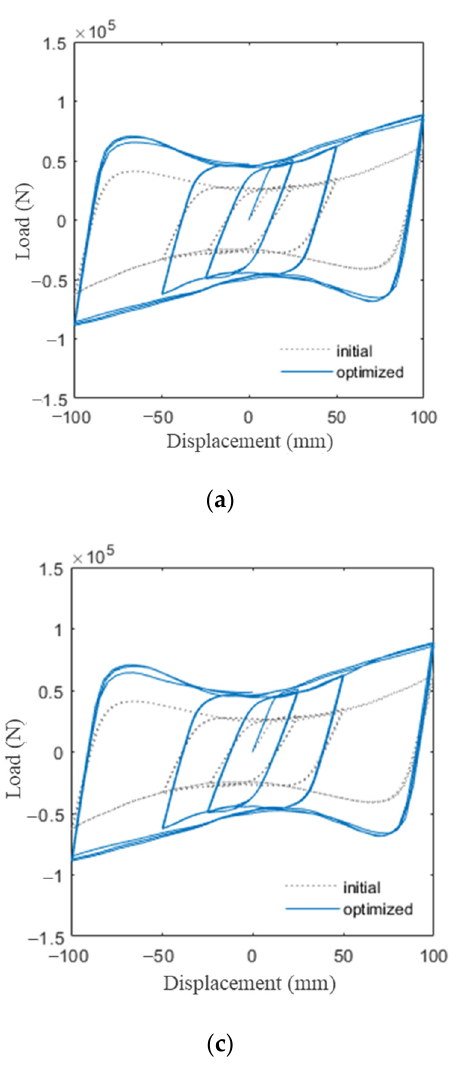
Figure 7. Plastic strain distribution (initial and S1) and stress distribution at the edge (S1).